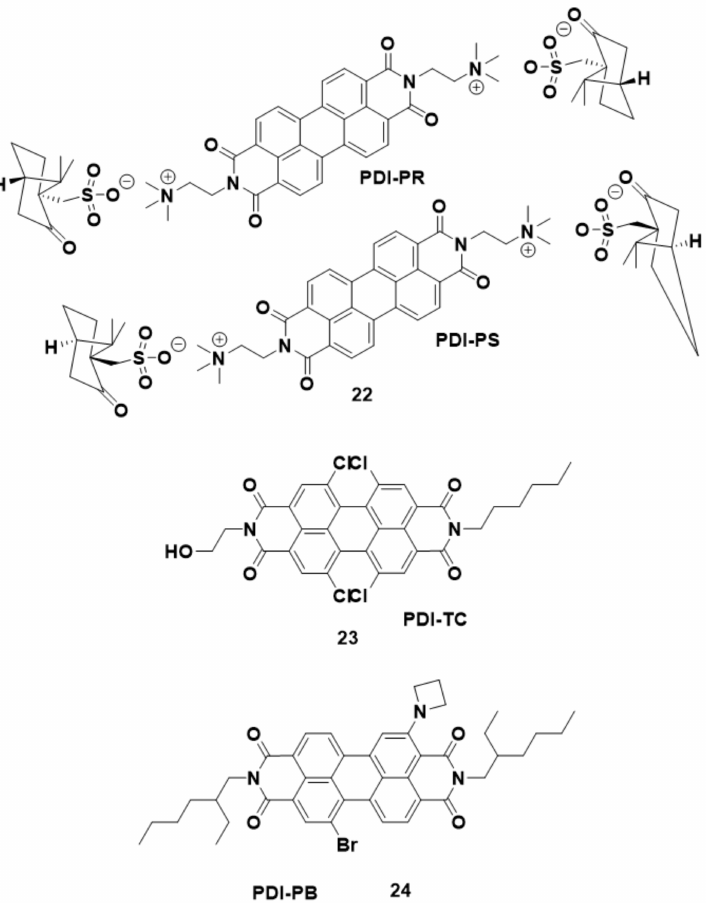
Figure 10. Chemical structures of the reported PDIs for hydrazine, ammonia, and other analyte